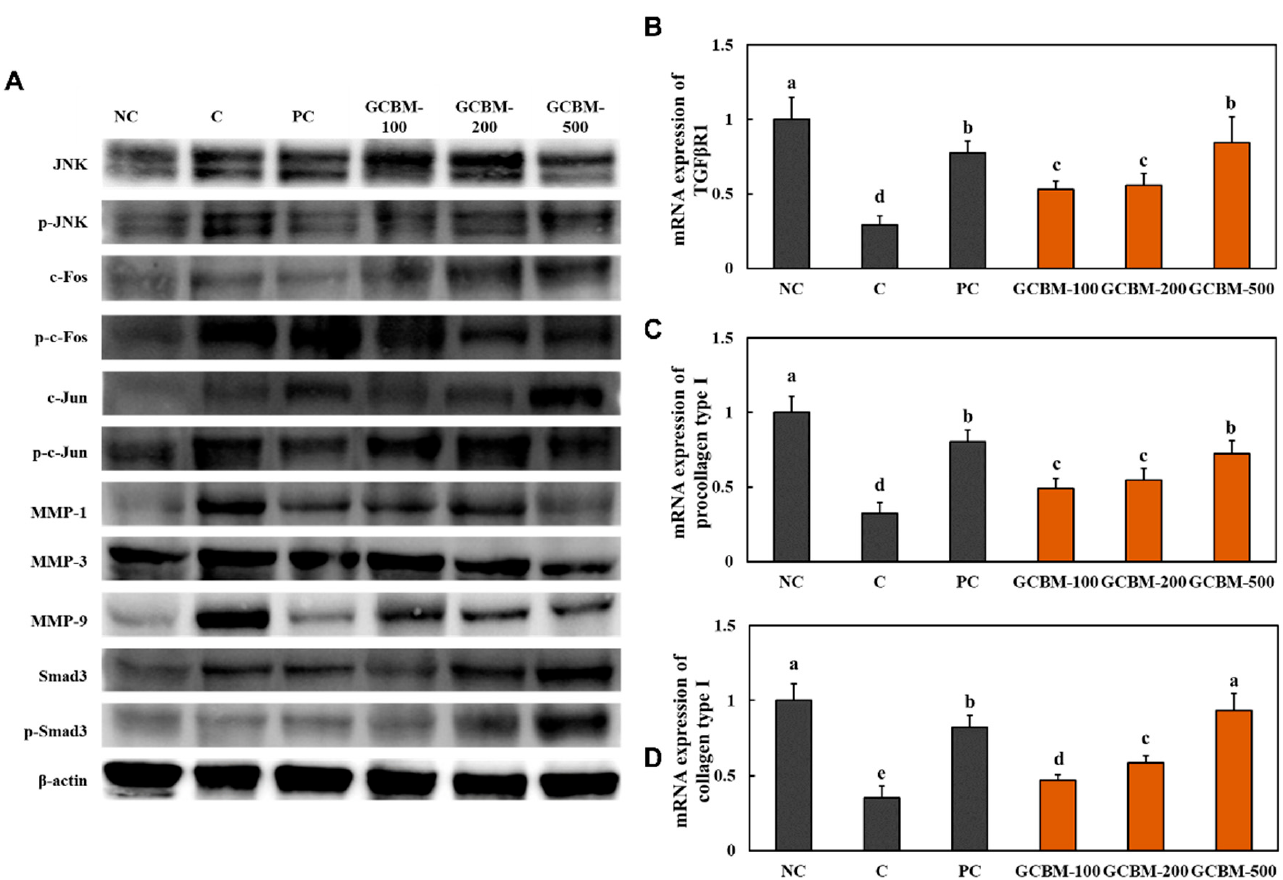
Figure 3. Effects of GCBM on protein expression of JNK/c-FOS/c-Jun/MMPs/Smad3 pathway ( A ), TGF - β RI mRNA ( B ), procollagen Type I mRNA ( C ), and collagen Type I mRNA ( D ) in the dorsal skin of UVB irradiation-induced photoaging in mice. Normal control (NC), control (C; UVB-irradiation), positive control (PC; UVB-irradiation with diet containing L -ascorbic acid at 100 mg/kg/body weight [b.w.]), GCBM-100 (UVB-irradiation with dietary supplementation of GCBM at 100 mg/kg/b.w.), GCBM-200 (UVB-irradiation with dietary supplementation of GCBM at 200 mg/kg/b.w.), and GCBM-500 (UVB-irradiation with dietary supplementation of GCBM at 500 mg/kg/b.w.). Values are presented as mean ± SD. Different letters (a > b > c > d > e) indicate a significant difference, with p < 0.05, as determined with Duncan’s multiple range